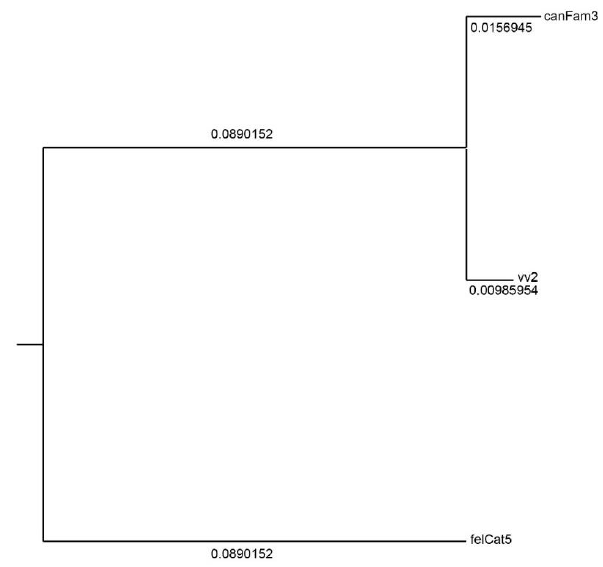
Figure A1. Newick tree visualization including branch lengths.